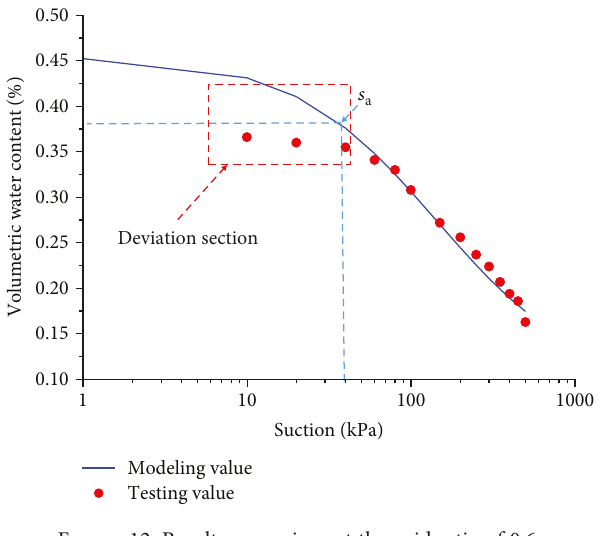
Figure 14: In fl uence of n on the SWCC.